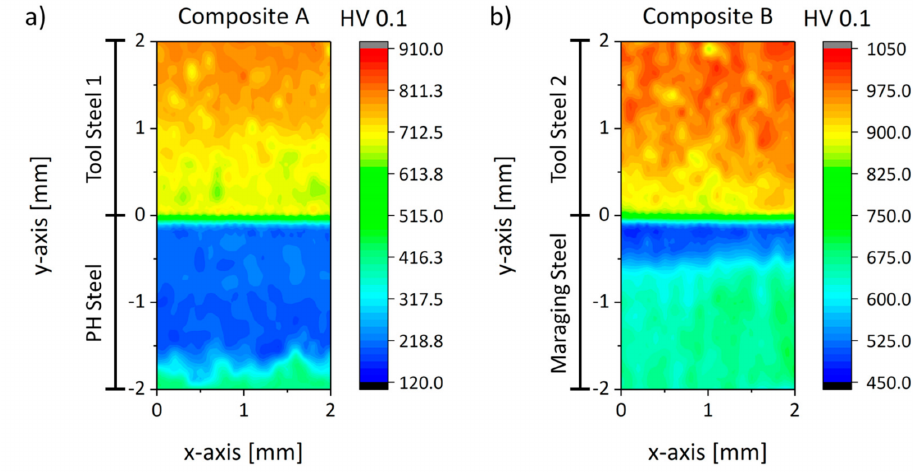
Figure 8. HV0.1 microhardness maps of the interface: ( a ) composite A, ( b ) composite B. For both composites, the area around the interface was softer than the respective base